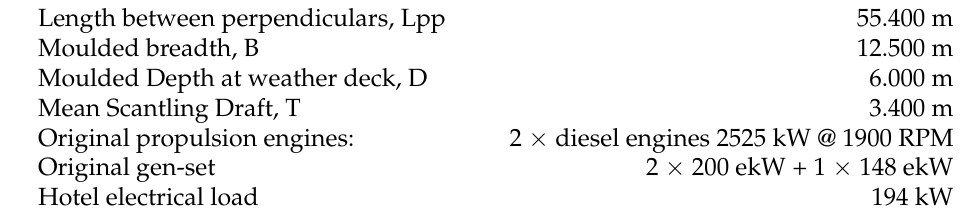
Table 1. Main data of the case study vessel. Length between perpendiculars,